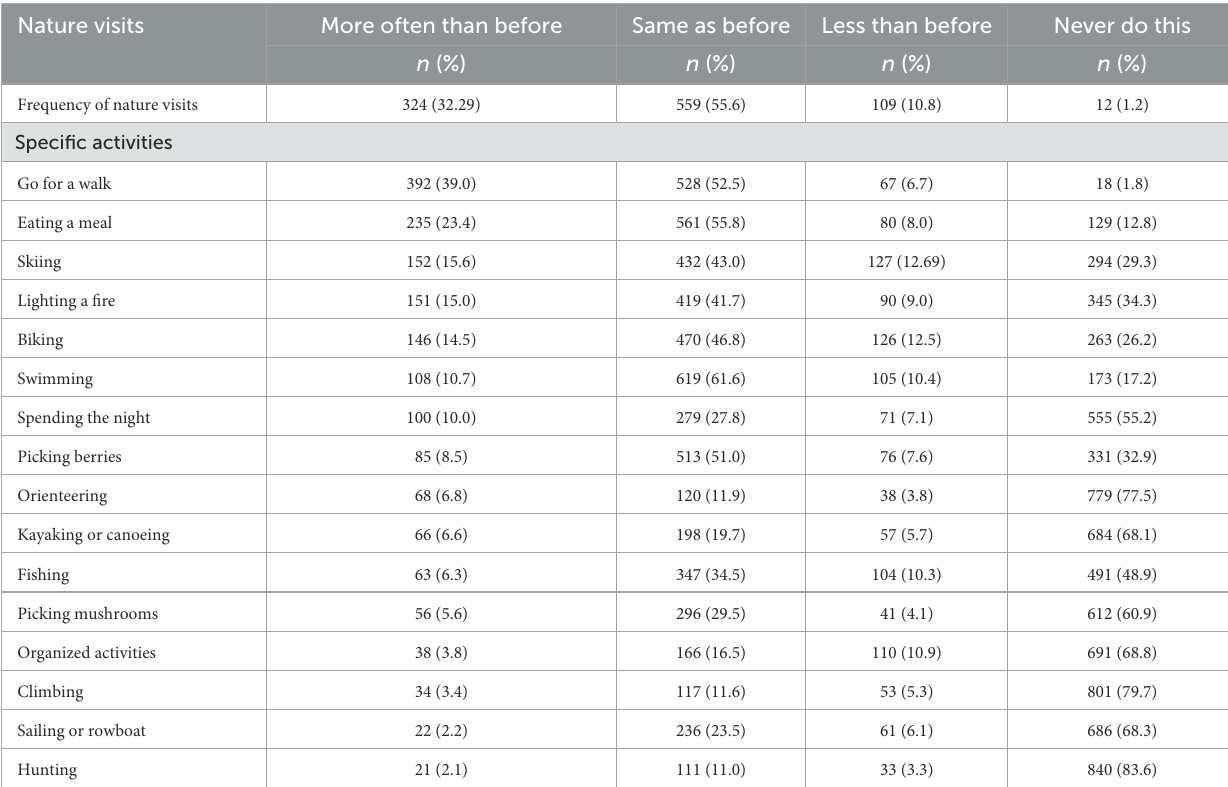
TABLE 2 Proportion of participants who either increased, maintained, reduced, or never engage in nature-based activities ( n =